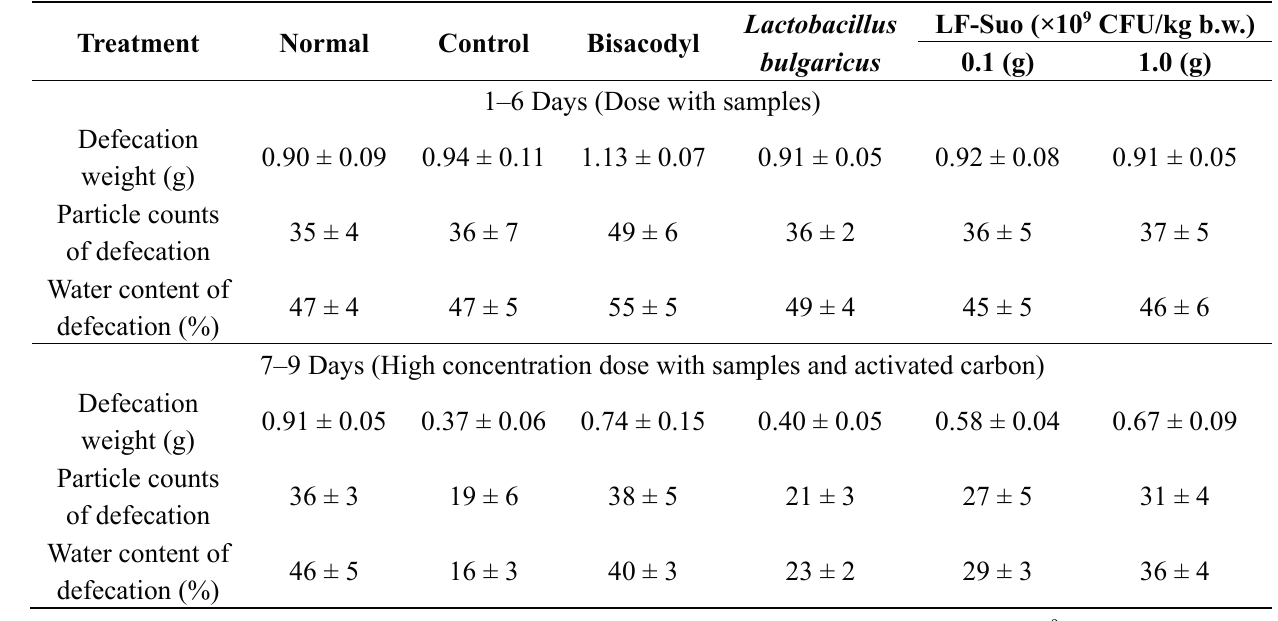
Table 4. Defecation status of mice during the